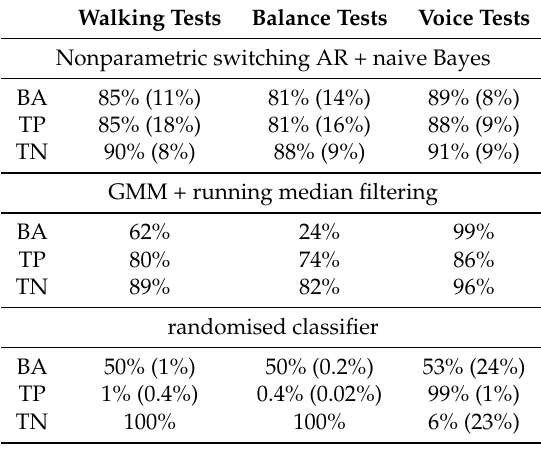
Table 2. Performance of the two proposed algorithms for quality control of clinimetric data and comparison with the randomised classifier. For the naive Bayes and the randomised classifiers, quality control predictions over all time points are evaluated using 10-fold cross-validation. We report the mean and standard deviation (in the brackets) of the balanced accuracy (BA), true positive (TP) and true negative (TN) rates across the different cross-validation trials changing the subsets of data used for training and testing. For the GMM-based approach, we report the BA, TP and TN rates using all the data for training and for testing since this approach is completely unsupervised; the standard deviation is not meaningful for a single trial (hence, standard deviations are